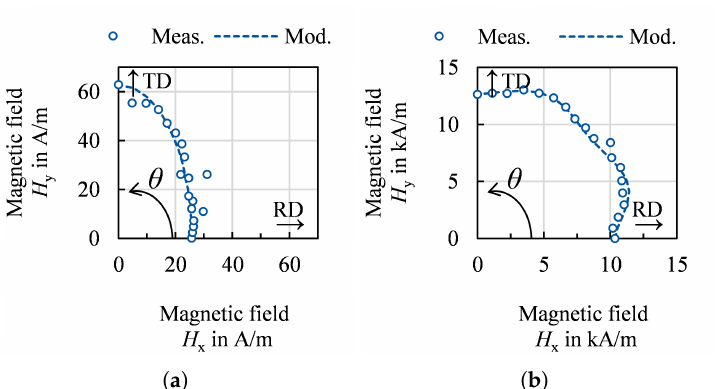
Figure 18. Comparison of continuously modeled and in 5°-steps measured magnetic field in the RD-TD plane at two different polarizations for a commercial M235-35A steel at 50Hz, ( a ) at 0.3T, ( b ) at 1.8T.